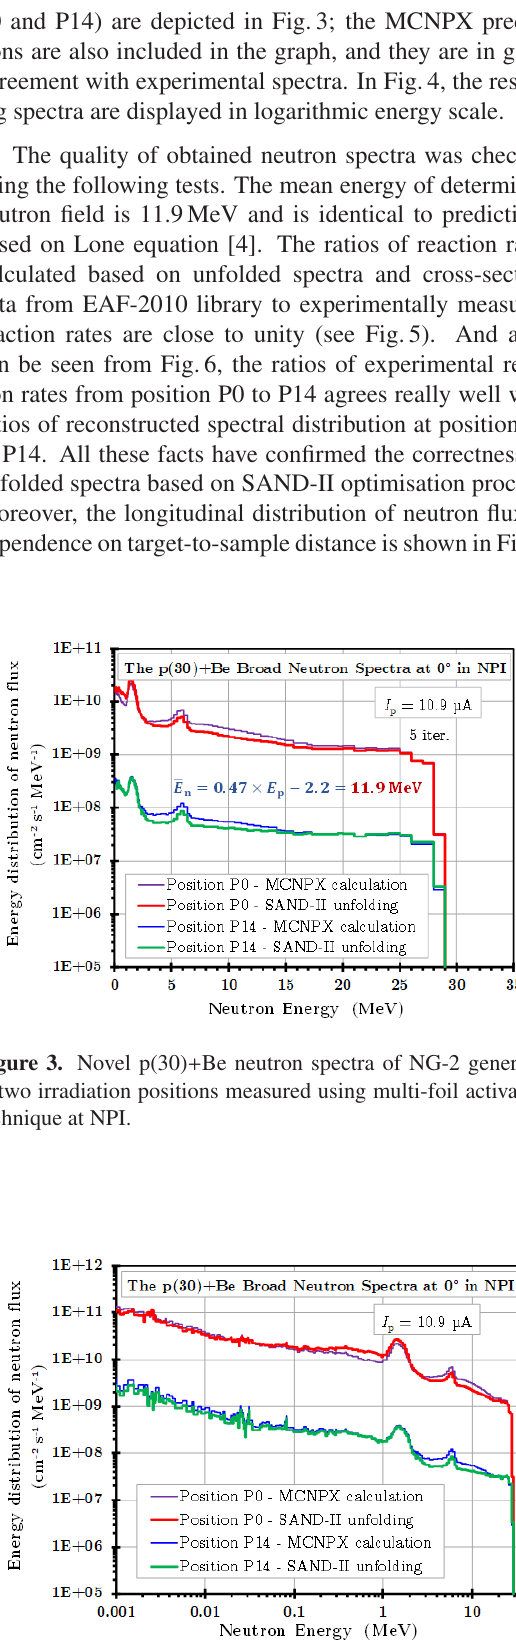
Figure 4. Novel p(30) + Be neutron energy spectra of NG-2 gen- erator at NPI in log-log scale.